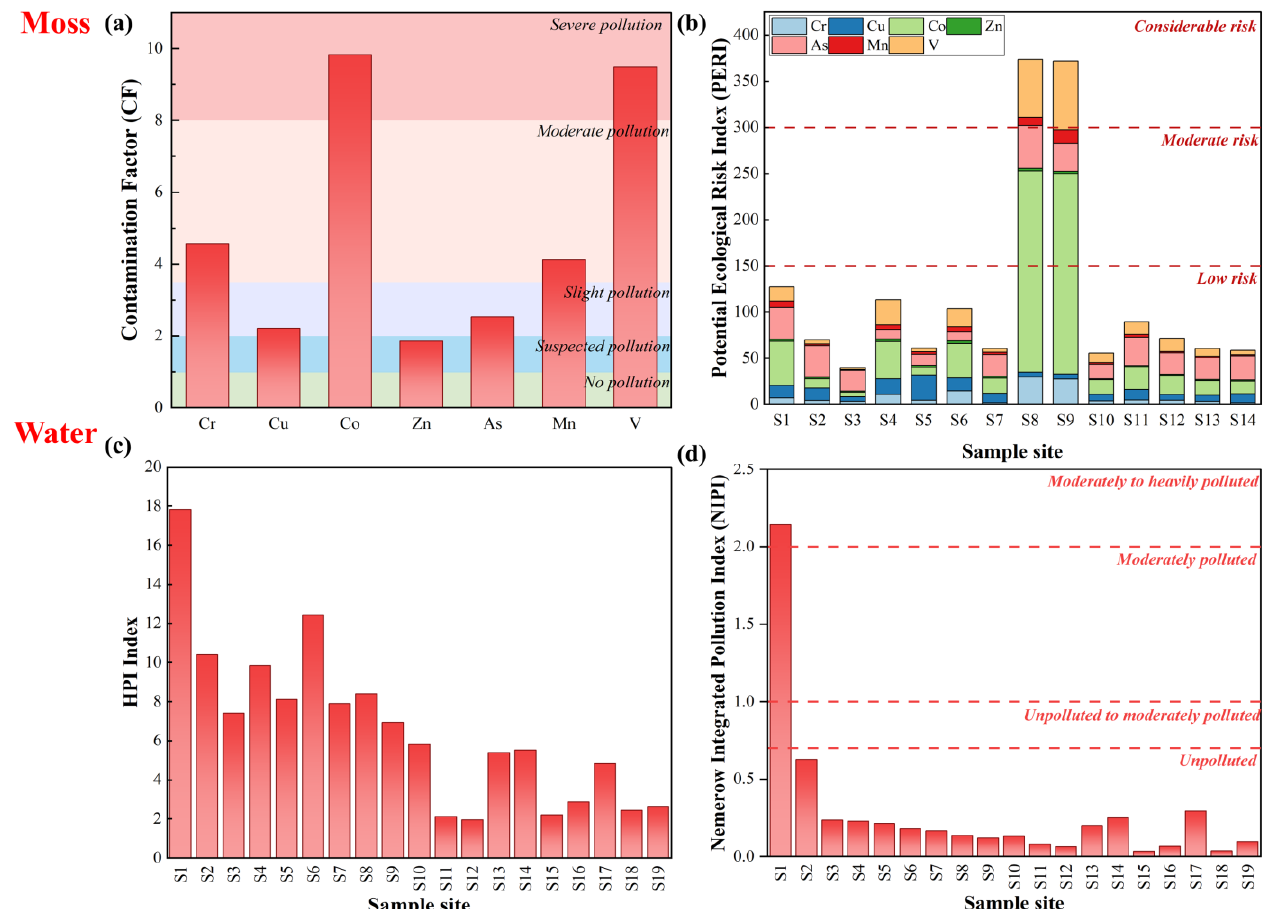
Figure 5. The contamination factors (CF) ( a ) and potential ecological risk index (PERI) ( b ) of metal (loid)s in SNJ moss; the HPI index ( c ) and the Nemerow integrated pollution index ( d ) of metal(loid)s in SNJ water.